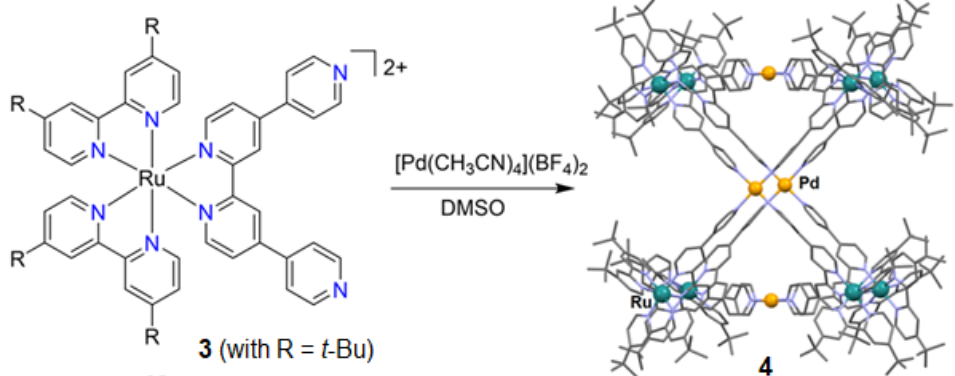
Figure 2. Synthesis and crystal structure (hydrogen atoms and BF 4 − anions are not shown) of the “open” cubic cage 4 starting from the bipodal metalloligand 3 (with R = t -Bu) [102].